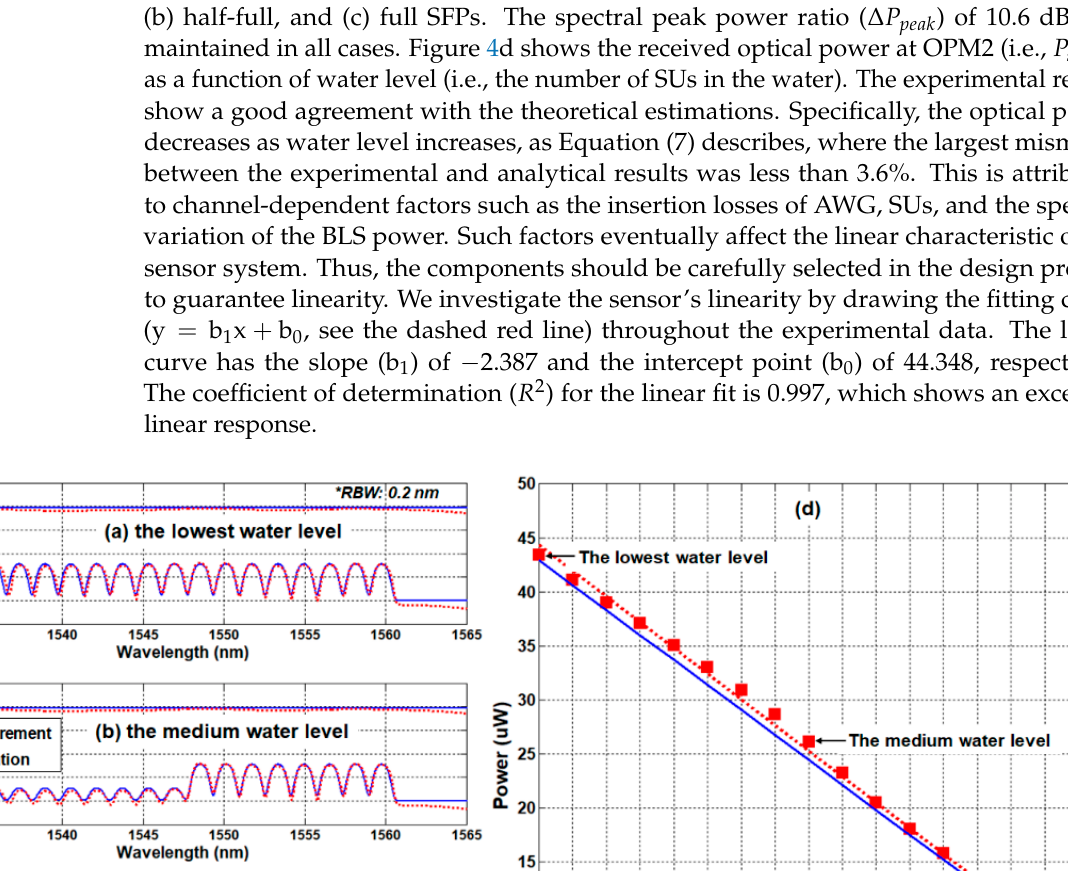
Figure 3. Experimental setup for demonstration of the dense wavelength division multiplexing